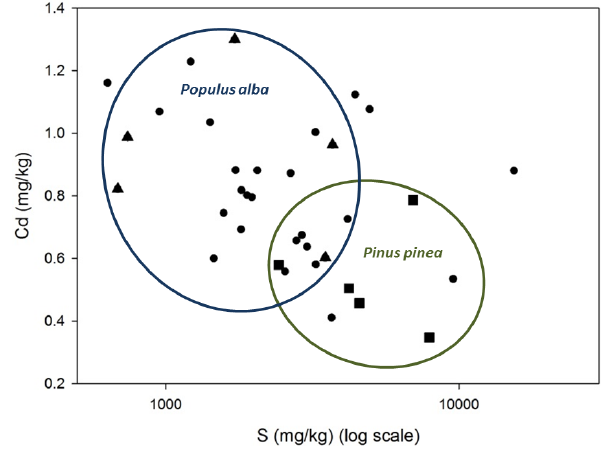
Figure 1. Bivariate diagram of the concentration of Cd and S (log scale) in the superficial soil under the 35 trees of 7 species. For il- lustrative purpose two contrasted species, Populus alba (triangle) and Pinus pinea (square), are indicated that showed pair-wise sig- nificant differences in S ( t value of 2.6, p = 0 . 03) and Cd ( t value of − 3.0, p = 0 .